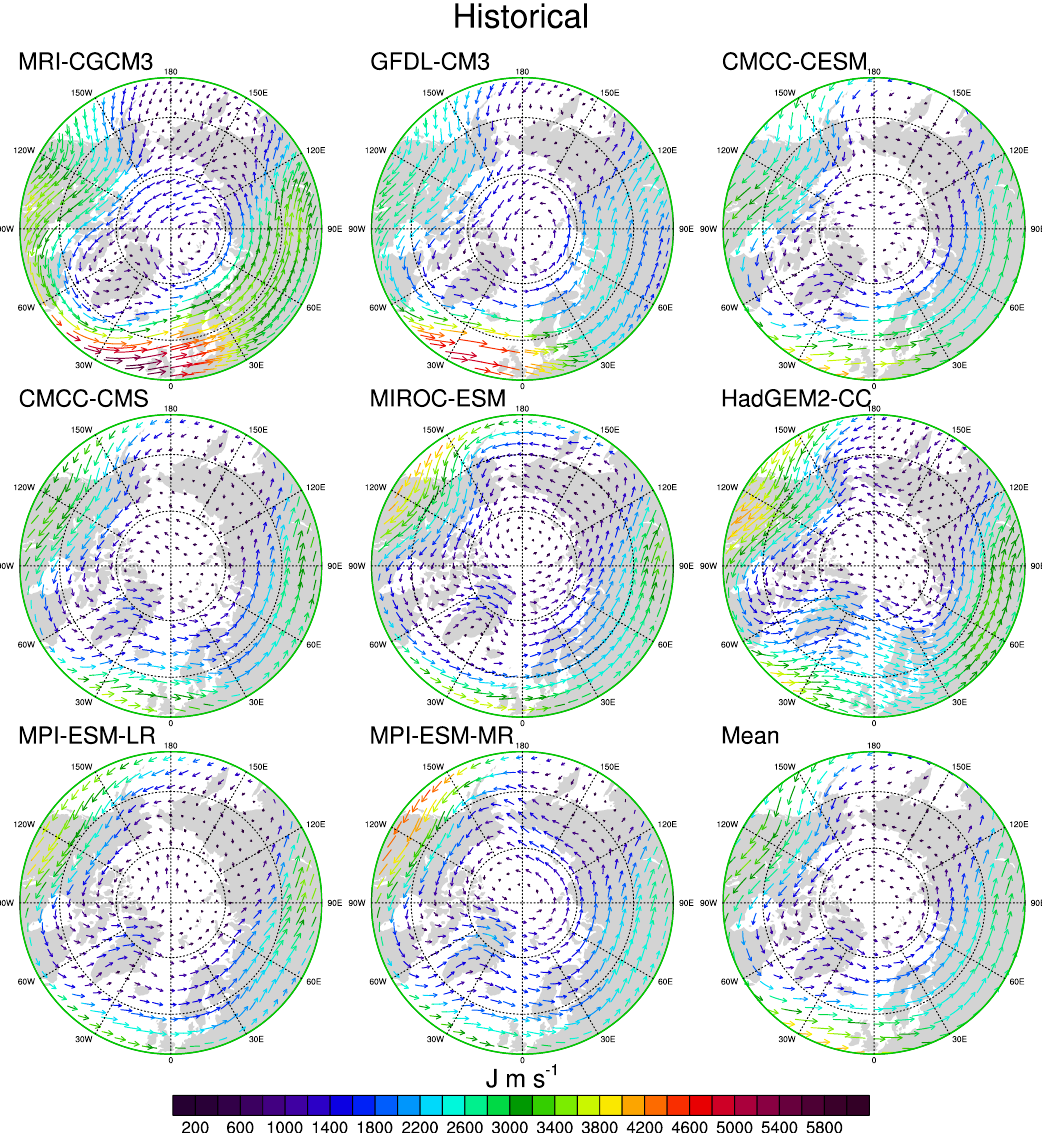
Figure 2. Same as in Figure1, but for the Continental